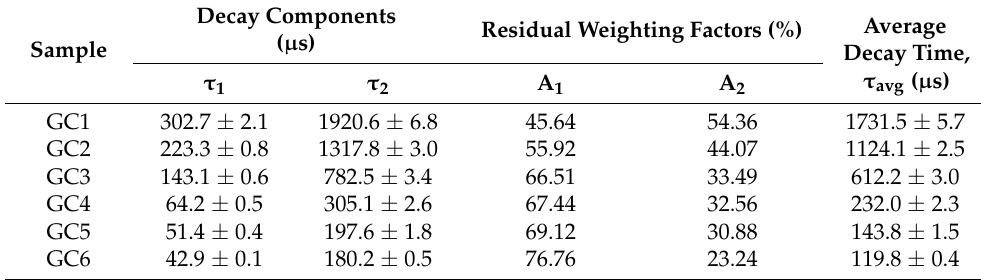
Table 6. Decay components ( τ n ), residual weighting factors (A n ), and average decay times ( τ avg )